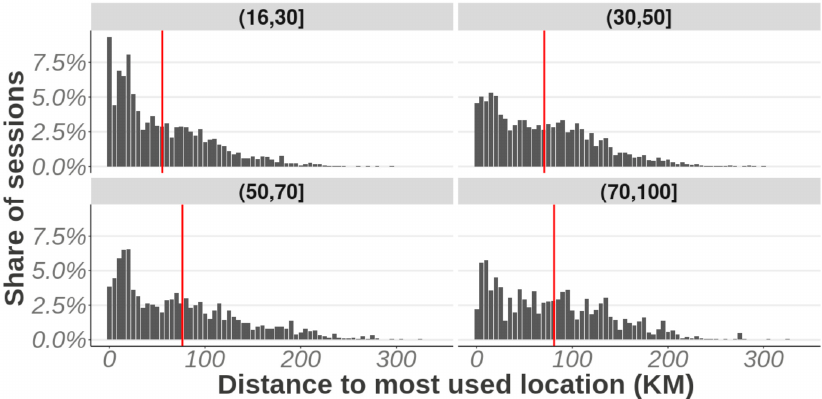
Figure 6. Distribution of distances to most used location for fast charging sessions for given range of battery capacity. Red line indicates average value.